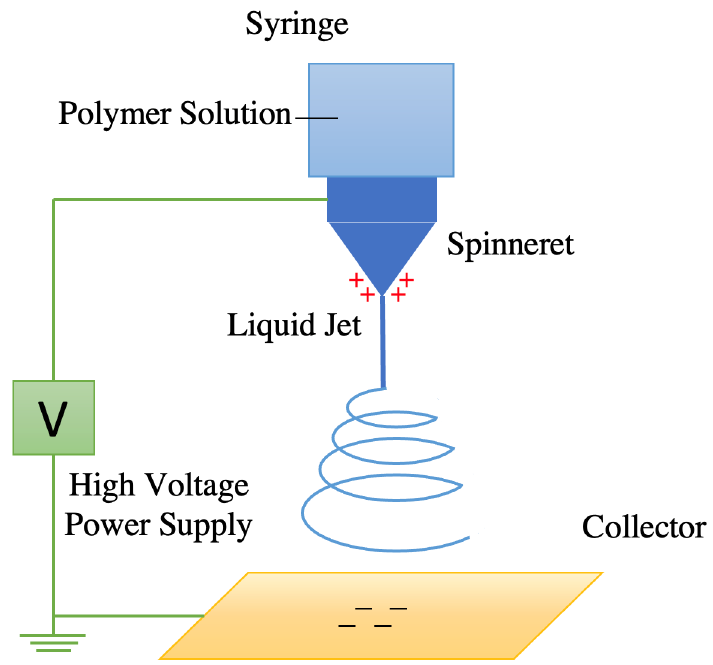
Figure 2. Schematic Diagram of Electrospinner Creating Carbon-Based Polymer